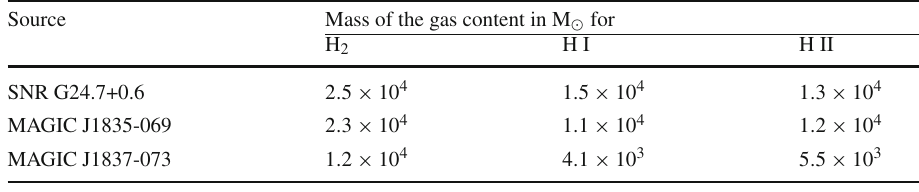
Table 2 The mass of the gas content in the sources at 6.6 kpc